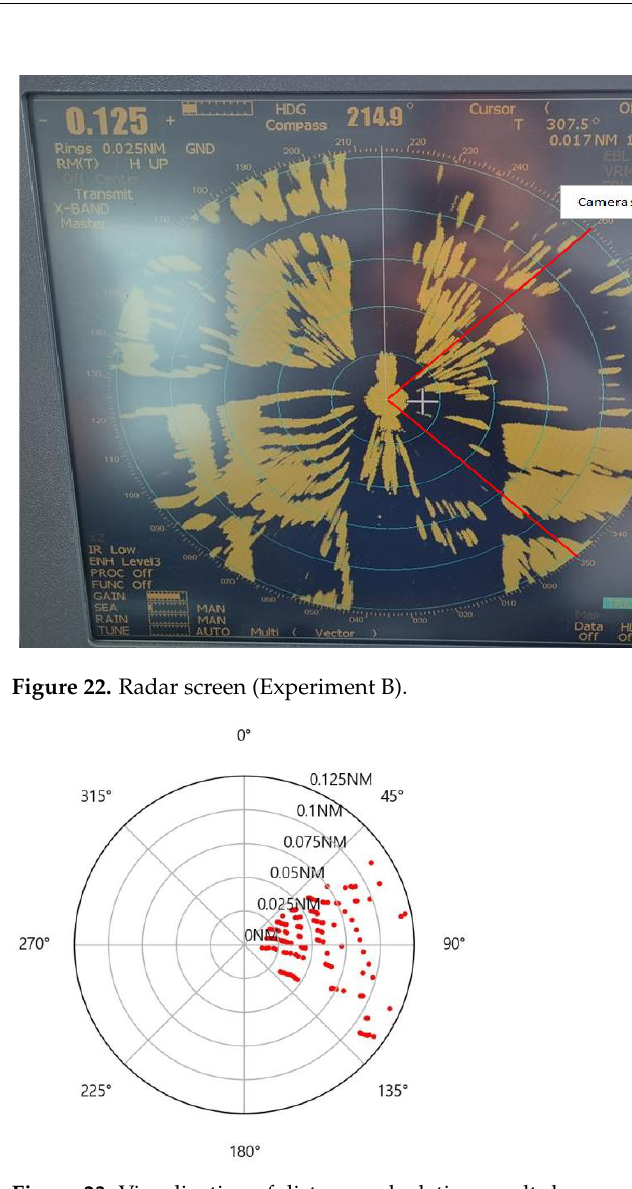
Figure 23. Visualization of distance calculation results by monocular vision (Experiment B). Table 8. Comparison of distance calculation with distance measurement (Experiment